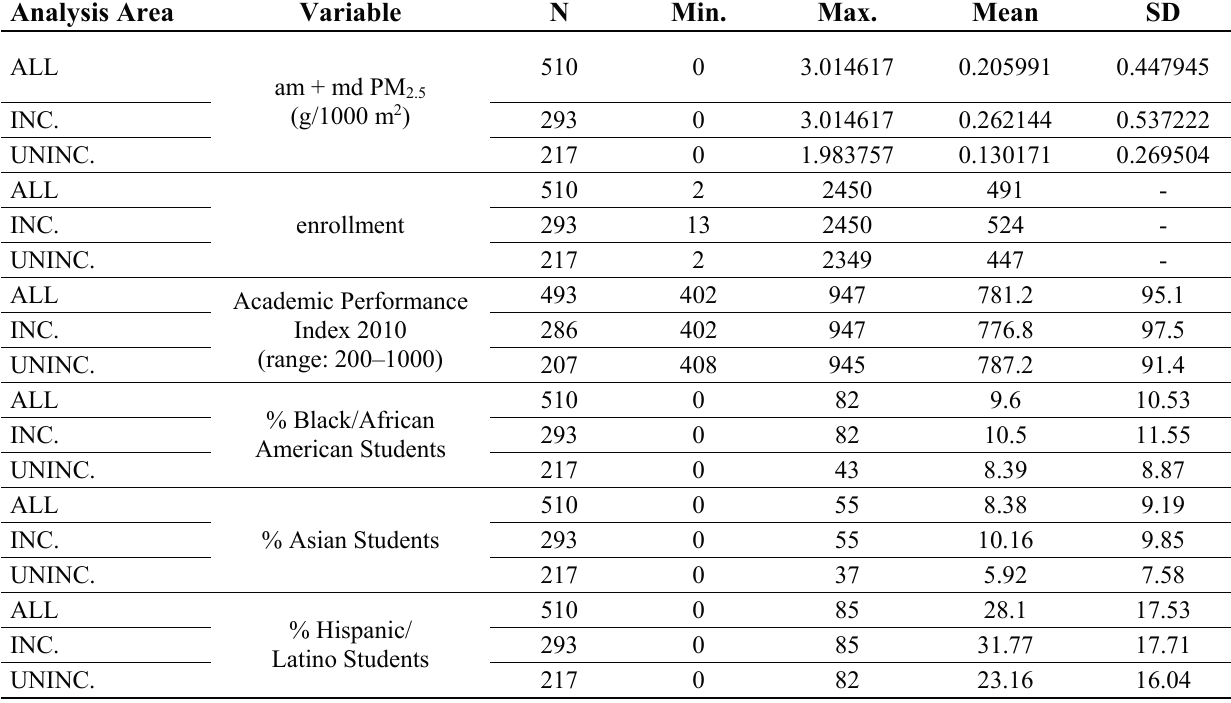
Table A1. Descriptive statistics for pollution burden, schools’ socio-economic characteristics and CES variables (health outcomes, road traffic related pollution